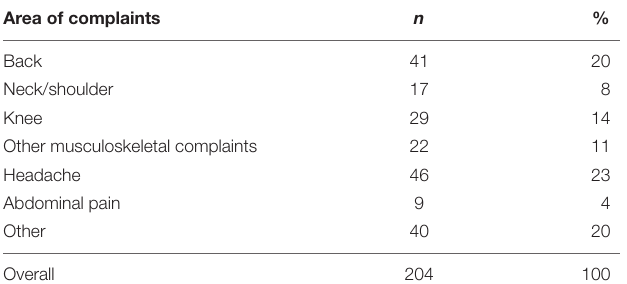
TABLE 2 | Physical complaints not connected to instrumental